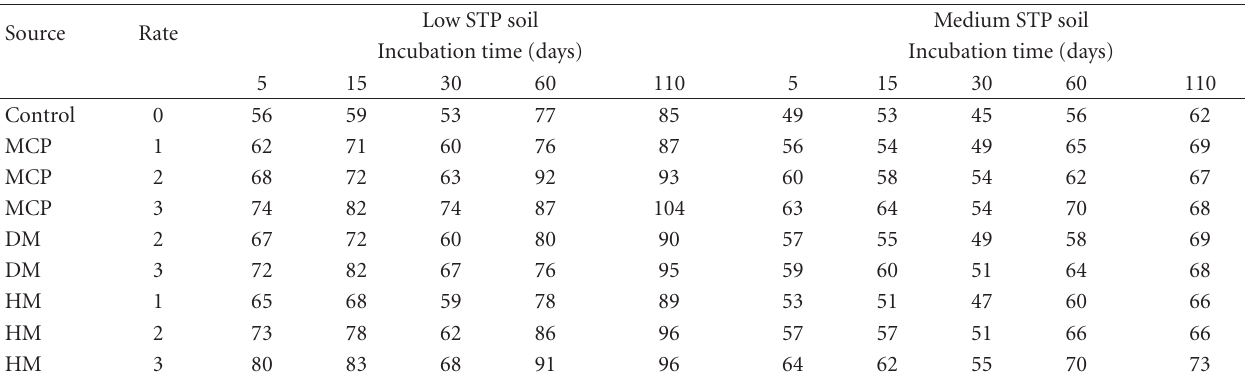
Table 4: Soil Test P (ppm) values for the control, as well as the fertilizer, the dairy manure, and the hen manure sources and their application rates at the five incubation times. The shown values are averages of three